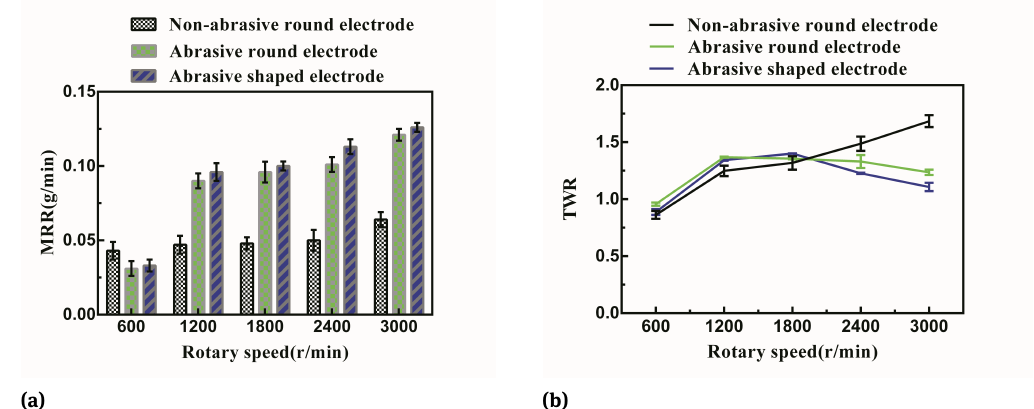
Figure 11: Influence of rotary speed on MRR and TWR (applied voltage = 120V, peak current= 25 A, pulse duration = 120 µ s, duty cycle =